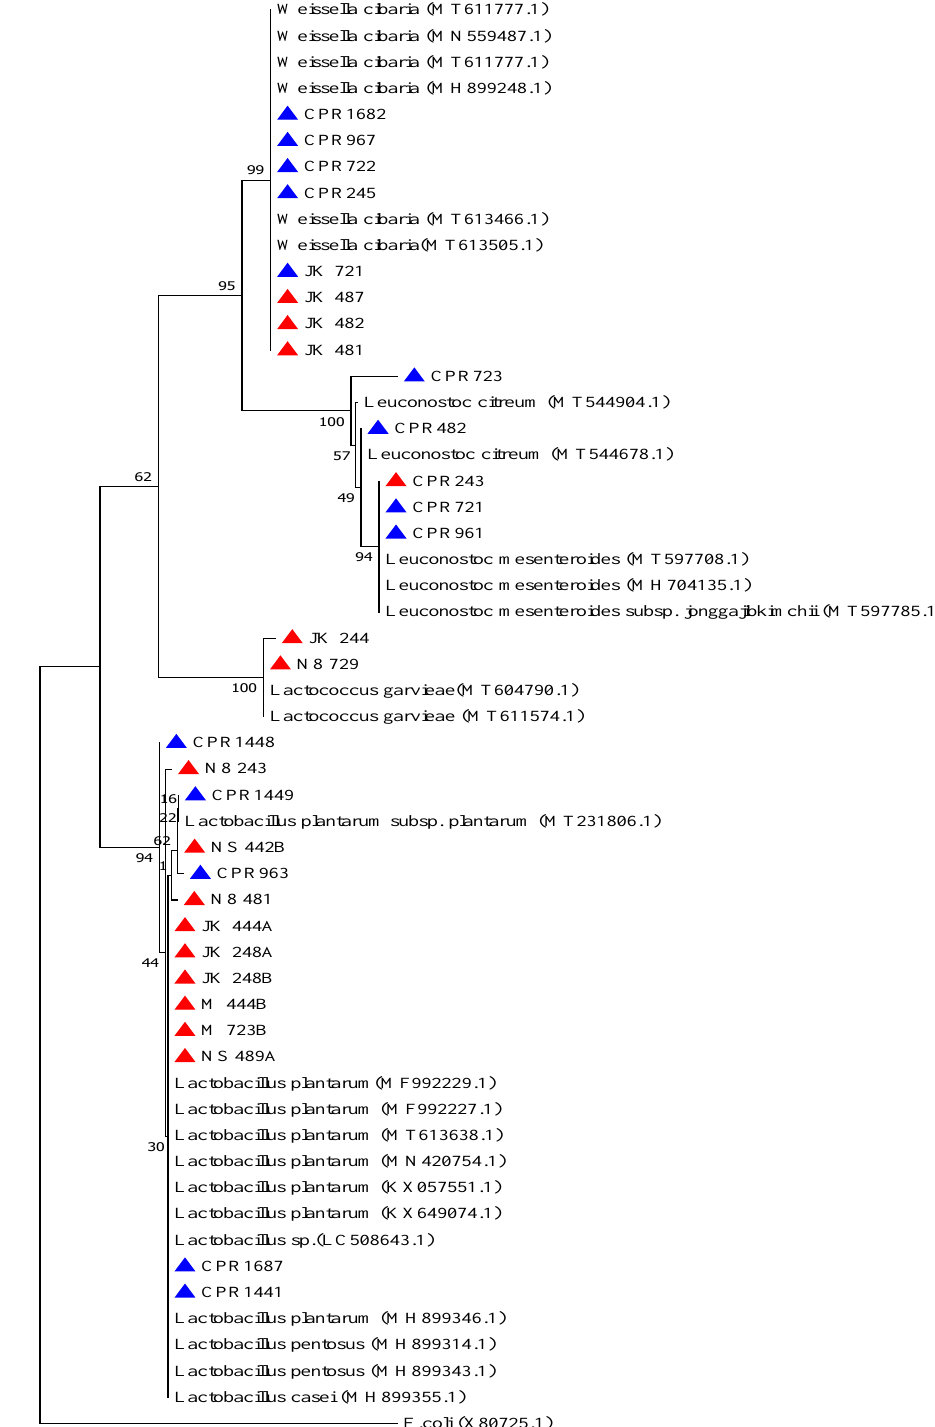
Figure 8 . A phylogenetic tree based on 16S rRNA gene sequences shows the relationship between lactic acid bacteria isolated from cowpea/amaranth and representatives of other related taxa. The scale bar indicates 0.05 substitutions per nucleotide position. The red arrows indicate isolates from amaranth and blue arrows indicate isolates from cowpea. The number beside the node is the statistical bootstrap value. In brackets are the GenBank accession numbers. The gene sequence of E. coli (X80725.1) was used as an